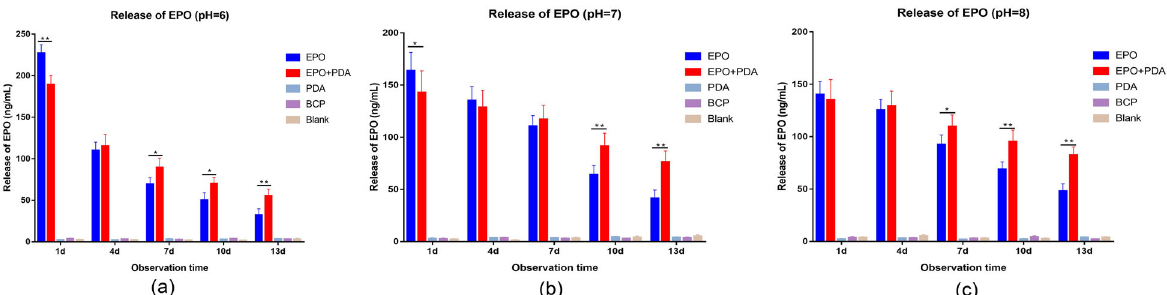
Fig. 5 a Staining of co-cultured cells 3 days after inoculation: The blue color represents the DAPI-stained cell nucleus, while the green color represents the phalloidin-stained cytoskeleton of various BCP bioceramics. b Cell viability of co-cultured cells 3 days after inoculation on different BCP bioceramics using the live and dead assay. The dead and live cells are indicated by red and green colors,